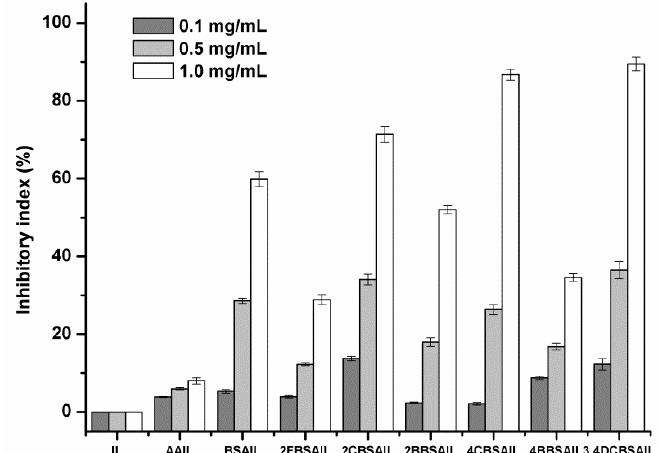
Figure 7. The antifungal activity of inulin, AAIL, and inulin derivatives against Fusarium oxysporum f. sp. niveum.